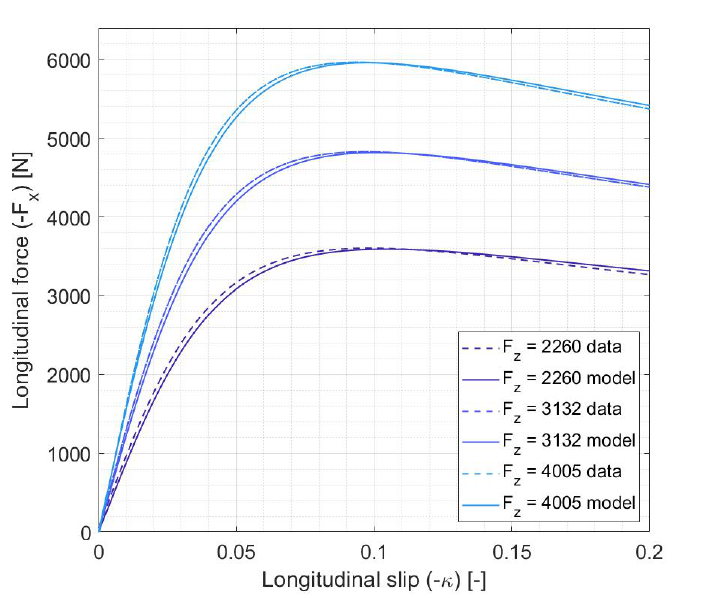
Figure 7. Pacejka-based force equation validation at reference temperature.